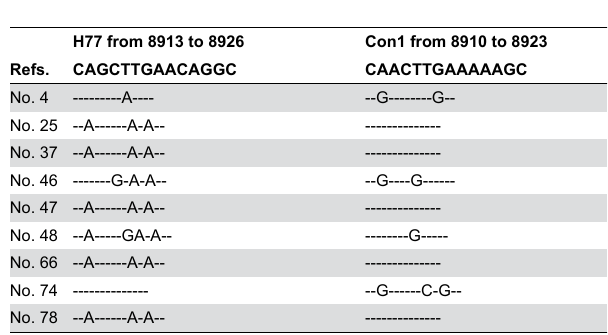
Table 3. Nucleotide sequences in MGB probe segments of each patient.